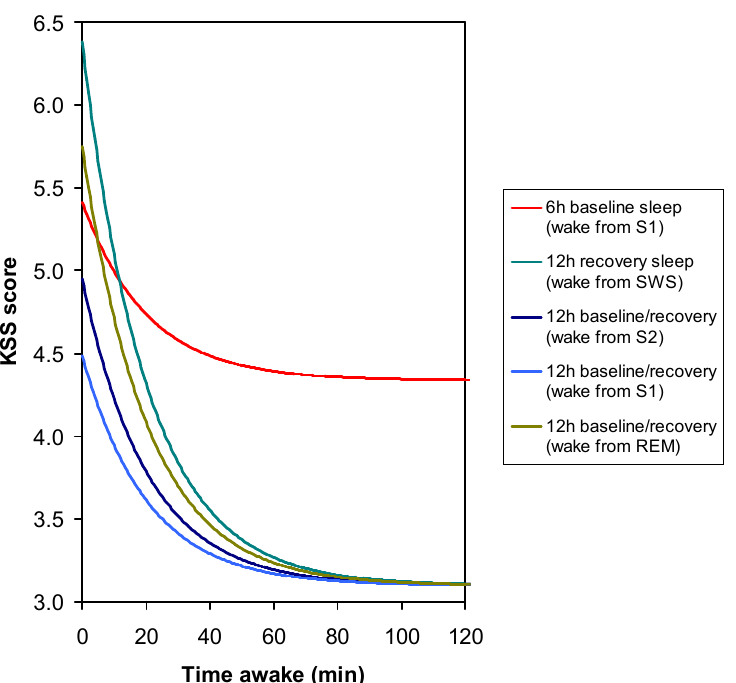
Figure 4. Nonlinear mixed-effects regression model for the KSS-1 administered immediately after scheduled awakening, as estimated for the first of the three laboratory sessions, comparing awakening from different stages of sleep and after prior sleep restriction. The curves display the group model for sleepiness (KSS score) from SI after the 12-h baseline sleep period in the PSE condition or the 12-h recovery sleep period, for which the trajectories overlap (except for awakening from slow wave sleep, which only occurred after recovery sleep), and after the 6-h baseline sleep period in the PSR condition (awakening from stage 1 sleep only). Note that the scale range on the ordinate is different from that in Figure 3.